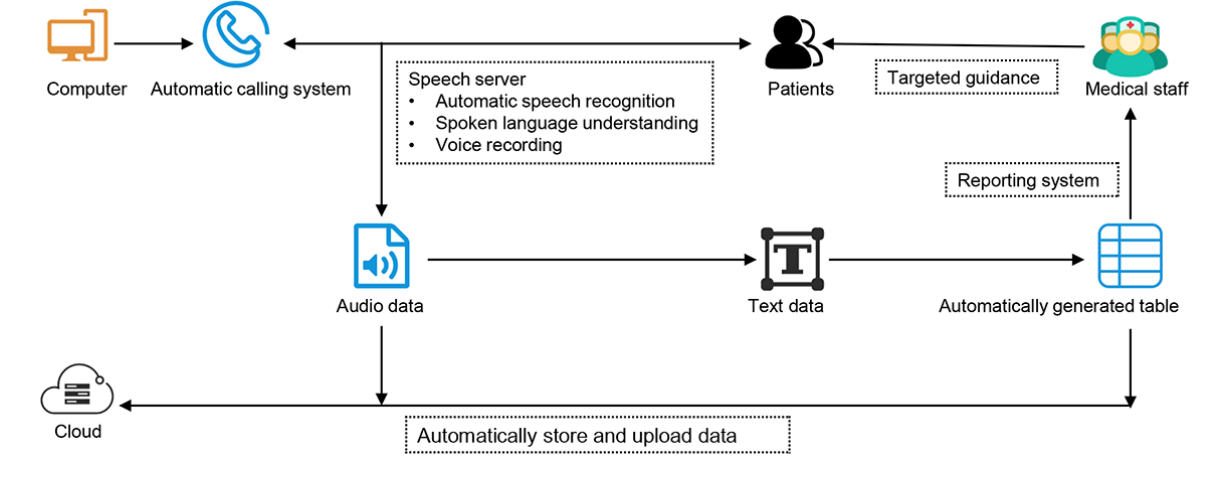
Figure 1. Block diagram of the AI-assisted follow-up